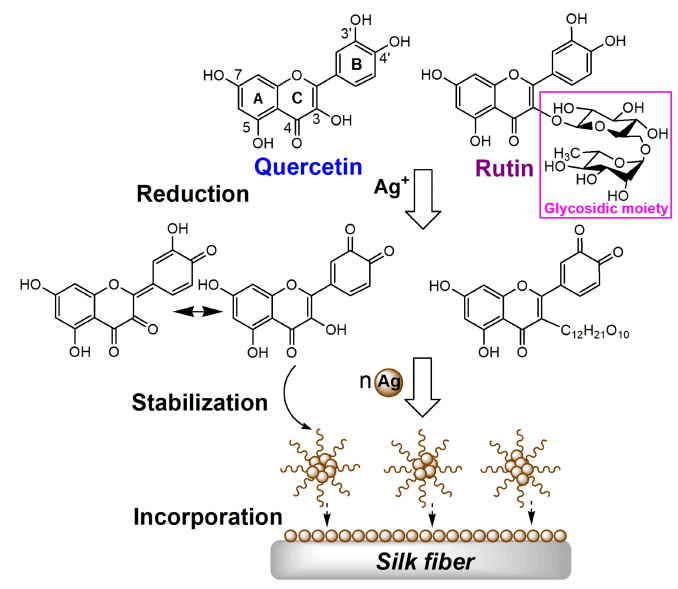
Figure 1. Scheme of the process of coating the AgNPs synthesized by flavonoids onto